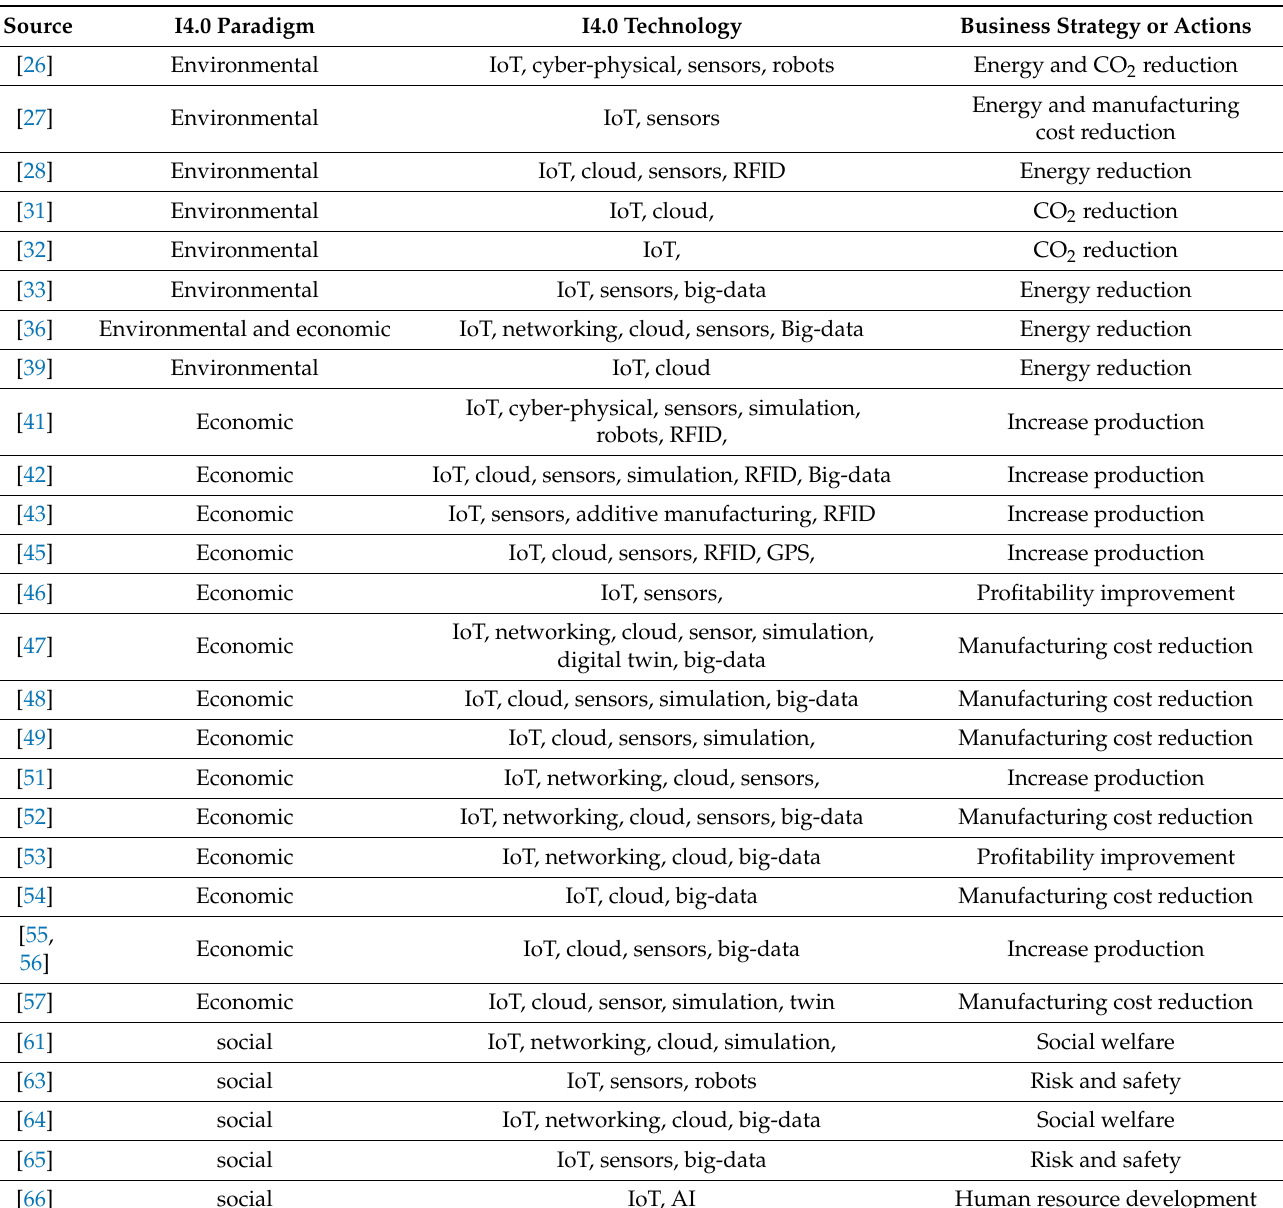
Table 4. Summary of case study and the analysis under I4.0 paradigm, technology and business